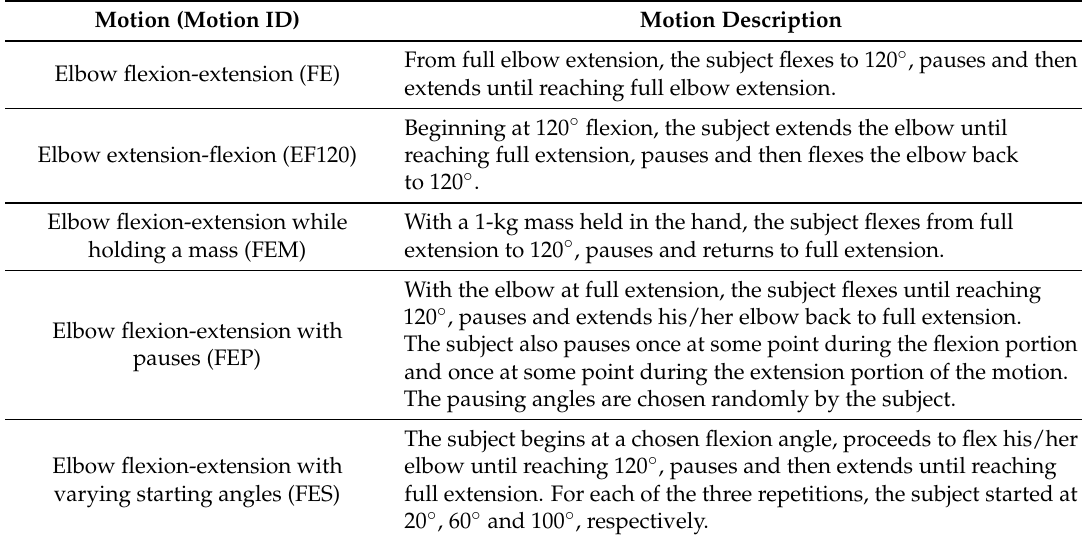
Table 4. Description of elbow motions used in the experimental